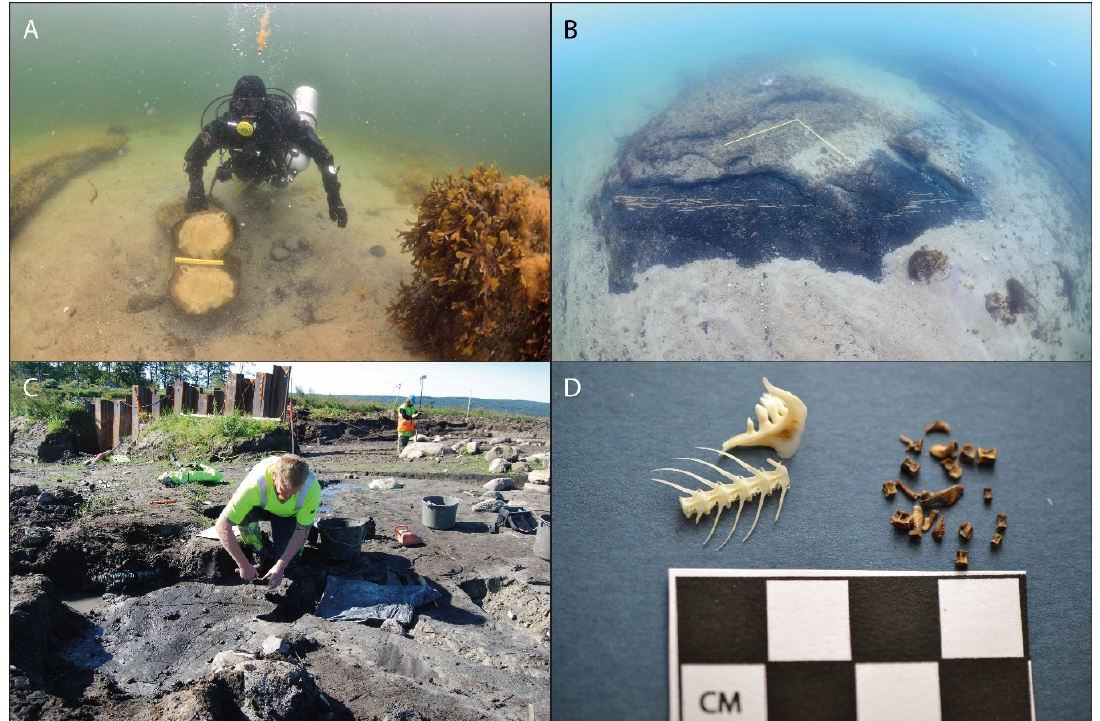
Figure 2. ( A ) A pine stem protruding from organic sediments covered by sand at 4.9 m b.s.l. at Haväng. An organic sediment ridge can be seen to the left. ( B ) A stationary fishing construction made of hazel rods, dated to about 8500 cal BP, found at 6 m b.s.l. at Haväng. ( C ) Excavation of the fish